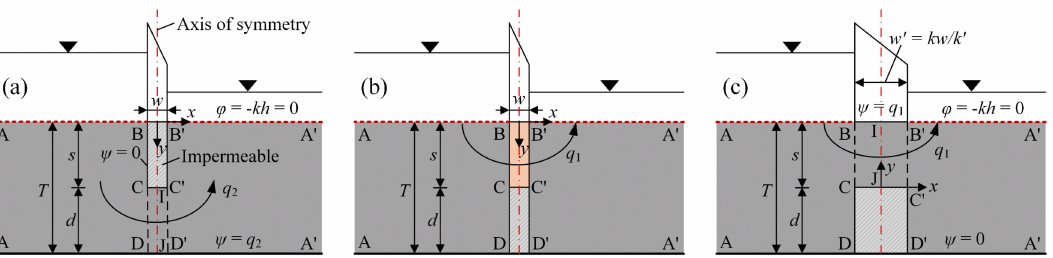
Figure 2. Two exact models: ( a ) model with only seepage under the wall; ( b ) model with only leakage through the wall body; and ( c ) equivalent model of ( b